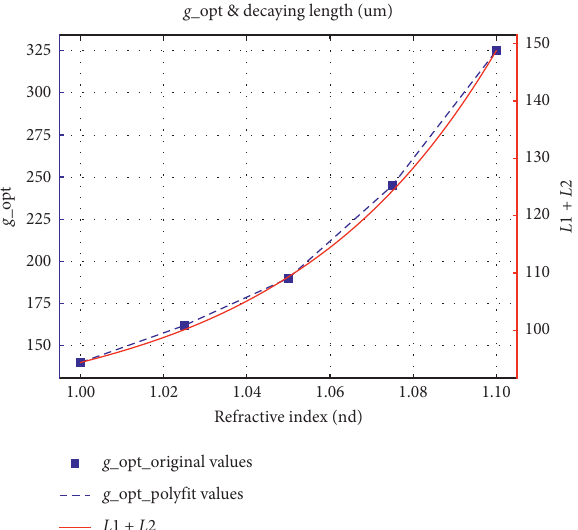
Figure 5: The fitting curve of the optimal gap and the attenuation curve of the electromagnetic field under different filled refractive